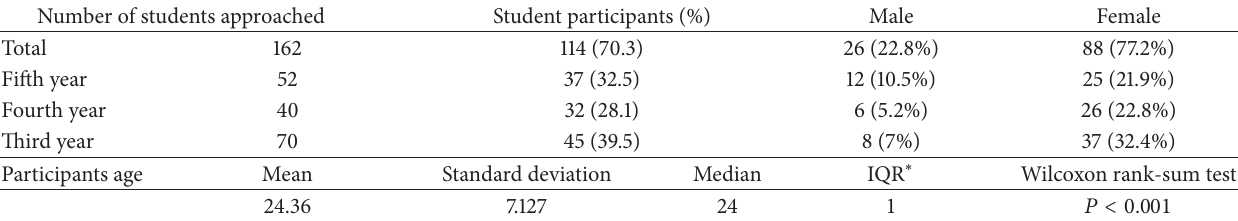
Table 1: Age and sex distribution of dental student